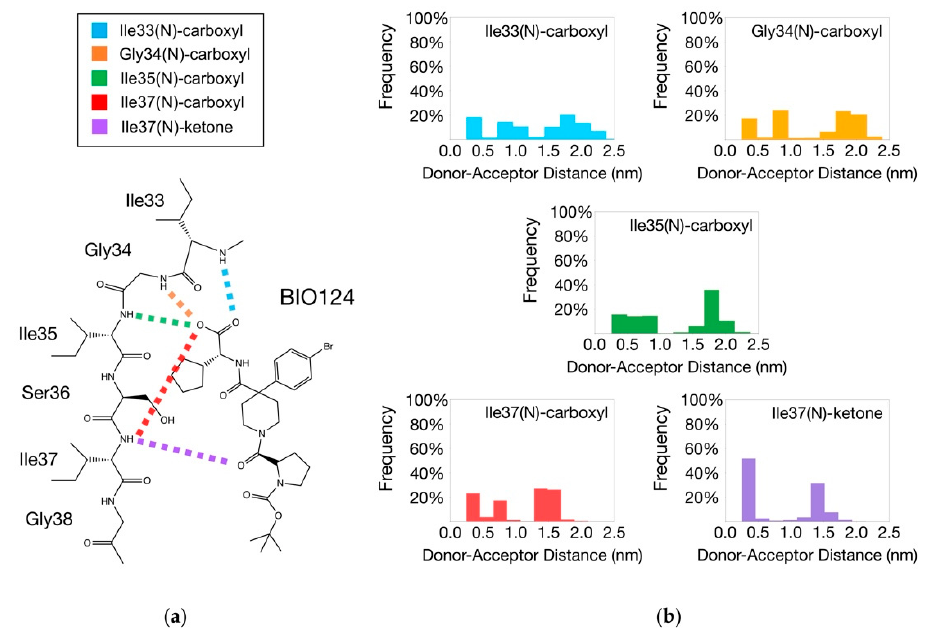
Figure 2. Hydrogen bonding network between BIO124 and the PICK PDZ domain. ( a ) Hydrogen bonds identified in both experimental work and our MD simulations include I33-carboxyl (cyan), G34-carboxyl (orange), and I35-carboxyl (green). Hydrogen bonds identified only in our MD simulations include I37-carboxyl (red) and I37-ketone (purple). ( b ) Distance distribution between each hydrogen bonding pair in the complex. Note that each hydrogen bonding pair produces distinct distance peaks.